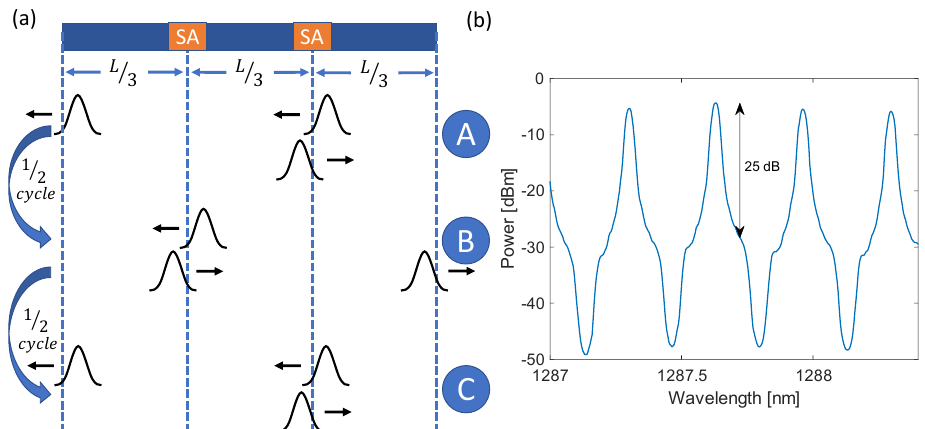
Figure 1. ( a ) Diagram of multiple pulses circulating in a 3rd harmonic colliding pulse mode-locked laser (CPMLL). A pulse is emitted from a facet per cycle. In position A, two pulses are colliding in the right saturable absorber (SA) and a pulse is being emitted from the left facet. The position of the three pulses half a cycle later is shown in position B. Two pulses are colliding in the left SA and a pulse is being emitted from the right facet. In position C, one full cycle has been completed and the position of the pulses are analogous to position A. ( b ) enlarged optical spectrum of a 3rd harmonic CPMLL.